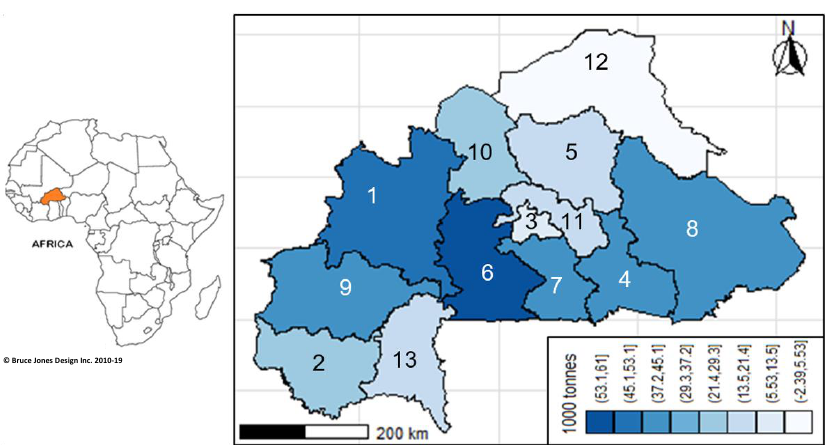
Table 2. Top 10 groundnut producing countries based on average area harvested in the last five years (2013–2017) [4].